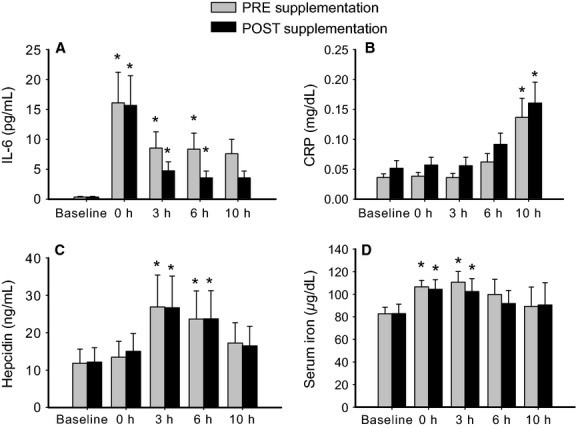
Exercise-induced response of IL-6 (A), CRP (B), hepcidin (C) and iron (D) in the serum before and after 28-days supplementation period with vitamins C and E. Error bars represent SEM. *designates significant differences (P < 0.05) compared to the corresponding baseline. No significant differences were found between pre and post vitamin supplementation.